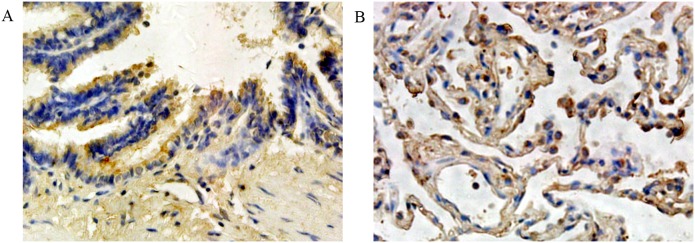
THOP1 was highly expressed in the cytoplasm of normal bronchial epithelium cells (A) and pneumocytes (B).